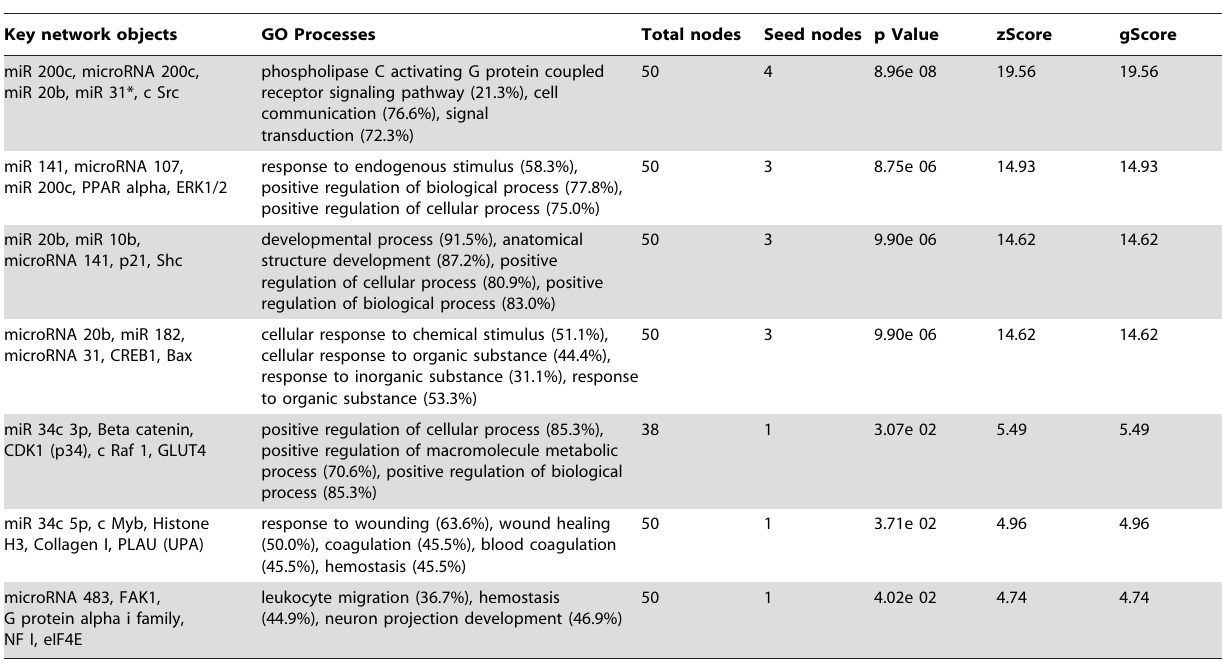
Table 5. Gene Ontological process affected by miRNAs.